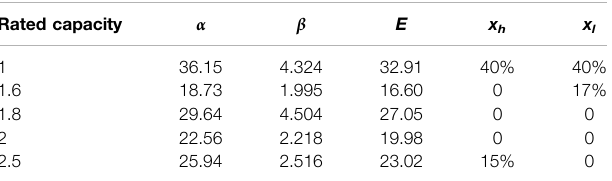
TABLE 1 | Corresponding parameters of equipment with rated